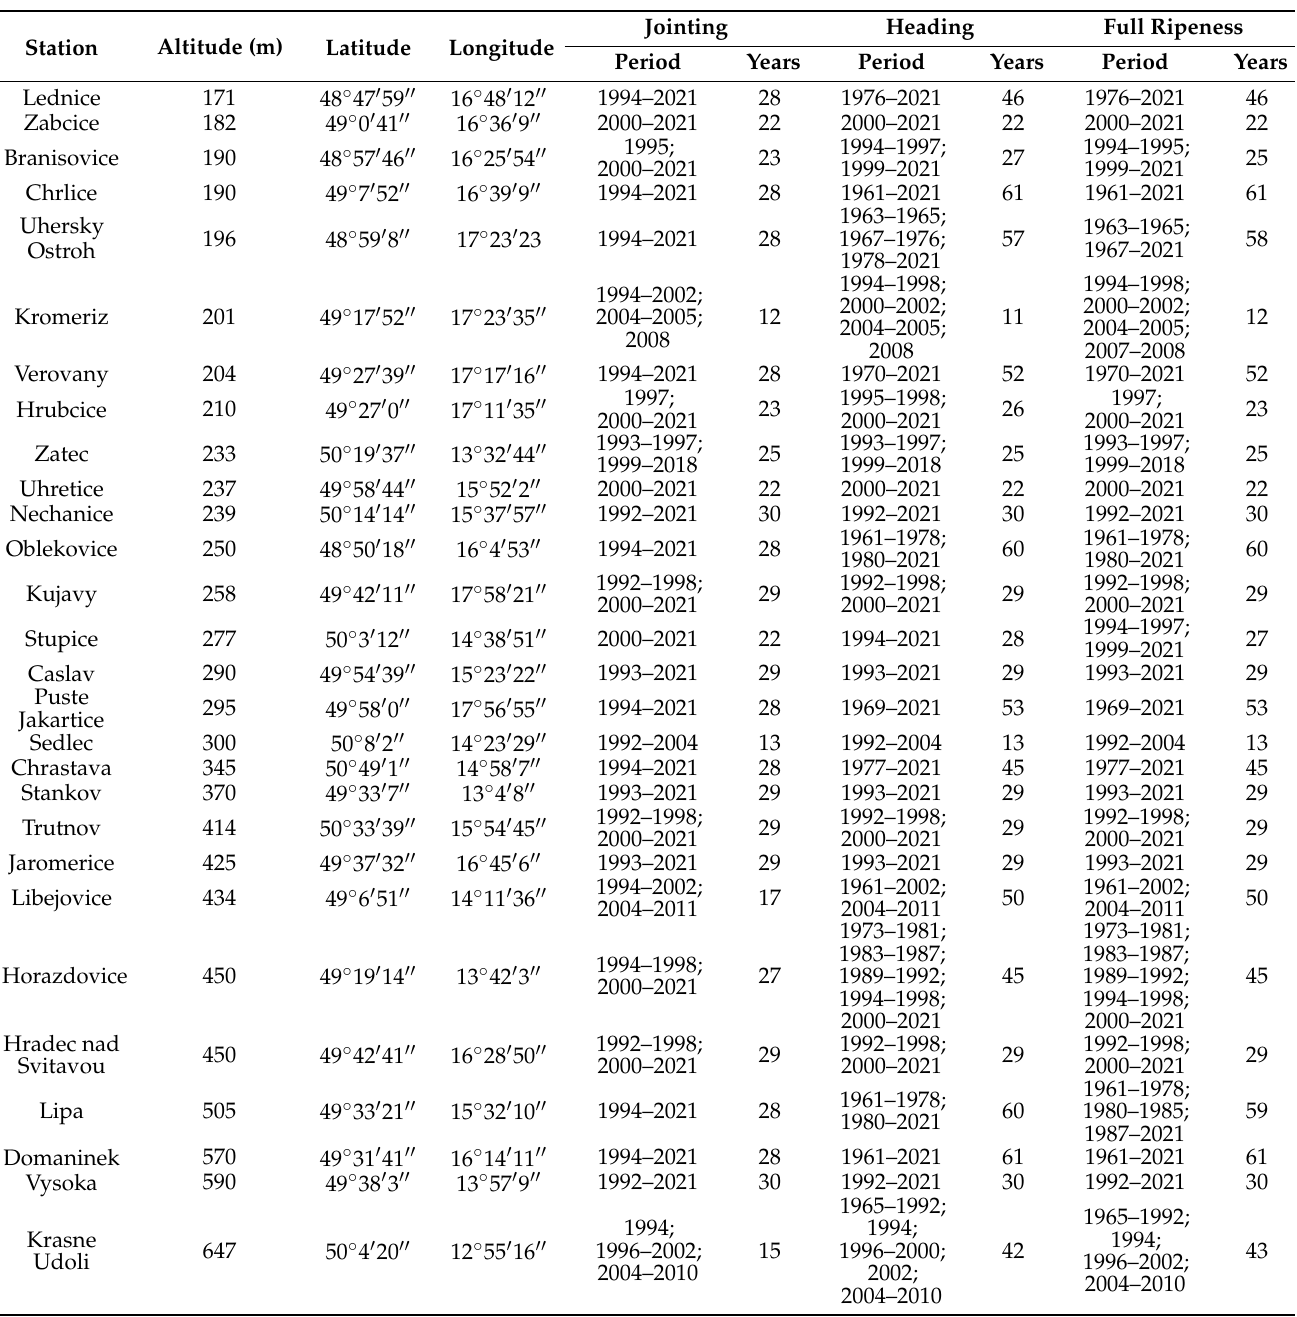
Table A1. An overview of experimental stations of the Central Institute for Supervising and Testing in Agriculture with phenological observations and their geographic coordinates (altitude (m.a.s.l.), latitude, and longitude). In the right half of the table, the time periods in which ground observations were available for each phenophase and each station are listed. The period column indicates a specific time period or year. The year column is the total number of years of ground observations for each